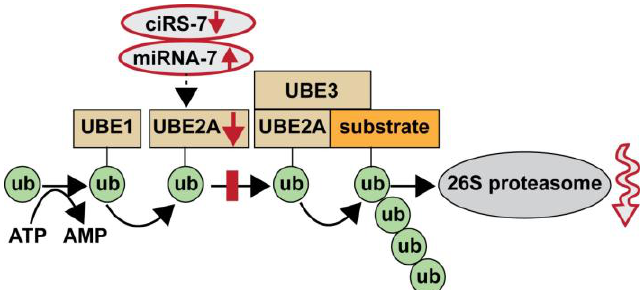
Figure 3. Highly schematicized illustration of deficits in the ubiquitination signaling pathway in AD that normally clears waste molecules (such as amyloid peptides) from the brain’s extracellular space: initially, a UBE1 enzyme activates, in an ATP-dependent manner, the 76 amino acid ubiquitin molecule by forming a high-energy thioester bond with ubiquitin; this E1-ubiqutin (UBE1) complex is next transferred to the ubiquitin conjugating enzyme (UBE2A); a ubiquitin ligase (UBE3) next positions the target substrate near the UBE2A enzyme allowing for the sequential transfer of ubiquitin; once a chain of four or more ubiquitin molecules is placed onto the substrate protein, the molecule is then targeted for proteolysis and degradation by the 26S proteasome; large and self-aggregating proteinaceous species (such as amyloids) once formed may be more difficult to ubiquitinate, sequester, and degrade [35]; a ciRS-7-driven miRNA-7-mediated lack of UBE2A near the center of this pathway would impair the trafficking of amyloid peptides and other neurotoxic end-stage molecules to the 26S proteasome complex [3–6,35,36]; note that in sporadic AD ciRS-7 is down-regulated (Figure 2) and ambient miRNA-7 is elevated, resulting in the down-regulation of UBE2A expression and an impairment at the UBE2A-ub stage (red rectangle) in the normal ubiquitination of end-stage molecules; this eventually leads to dysfunction and deficiency in the 26S proteasome system (downward wavy arrow at right).